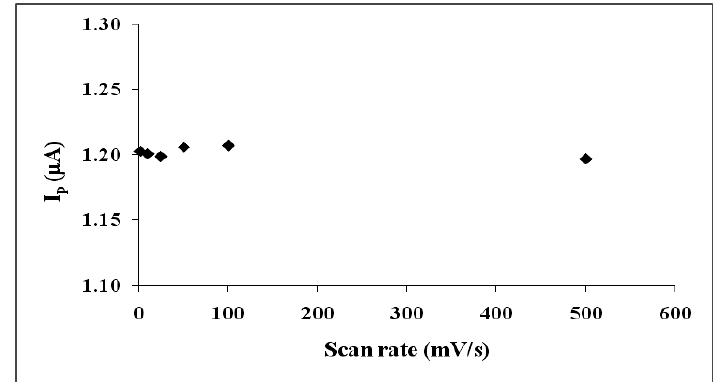
Figure 6. The effect of scan rate using UME-1 (at 2, 10, 25, 50, 100